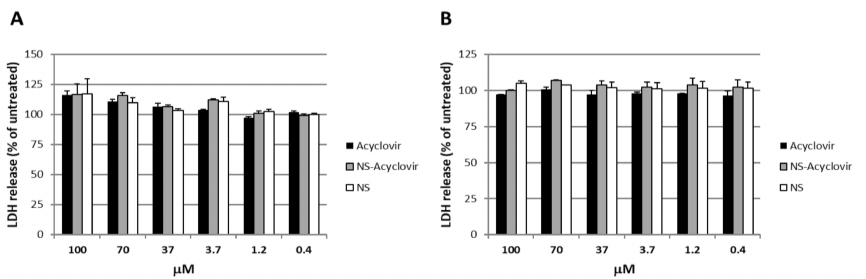
Figure 6. Cytotoxic effect of acyclovir, acyclovir-loaded NS, and NS alone on non-infected Vero cells by measuring the release of lactate dehydrogenase in culture medium at 24 h ( A ) and 48 h ( B ). X axis: nanospheres concentration, Y axis: release of lactate dehydrogenase (% of untreated control). Each point represents the mean ± SD ( n = 3).